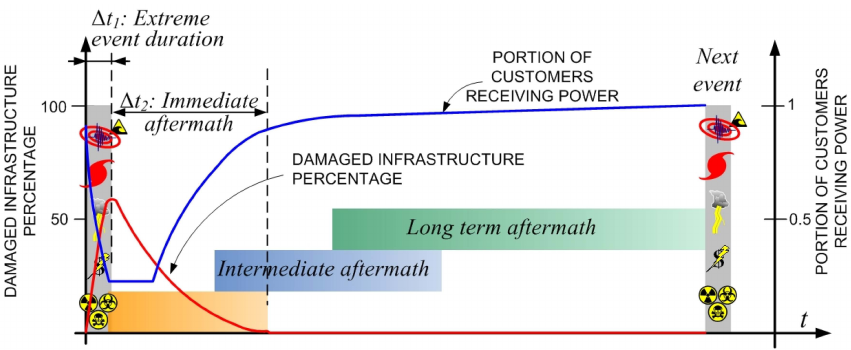
Figure 1. Representation of the phases of an extreme event. Both axes are not to